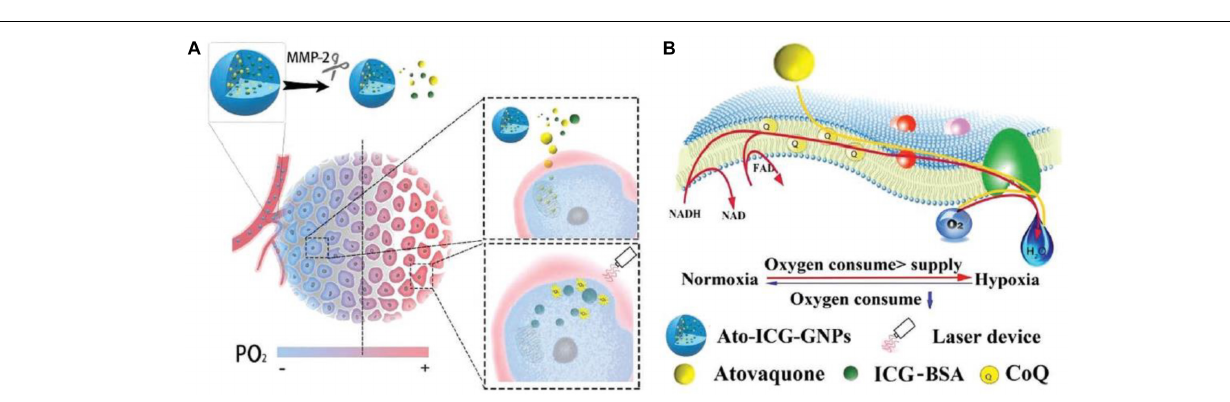
FIGURE 3 | (A) Schematic illustration of atovaquone (Ato) and indocyanine greenbovine (ICG) serum albumin nanocomplex encapsulated in gelatin nanoparticle for enhancing the tumoricidal effect exerted by photodynamic therapy treatment. Once entered into tumor, the gelatin nanoparticle was ruptured with the assistance of MMP-2, releasing ICG serum albumin nanocomplex and Ato. (B) A schematic showing the broad influence of Ato on oxidative phosphorylation, and the mechanism underlying the reverse of hypoxia as assisted by Ato and ICG serum albumin nanocomplex encapsulated in gelatin nanoparticle (reproduced with permission from Xia et al. (2019). Copyright 2019 John Wiley and